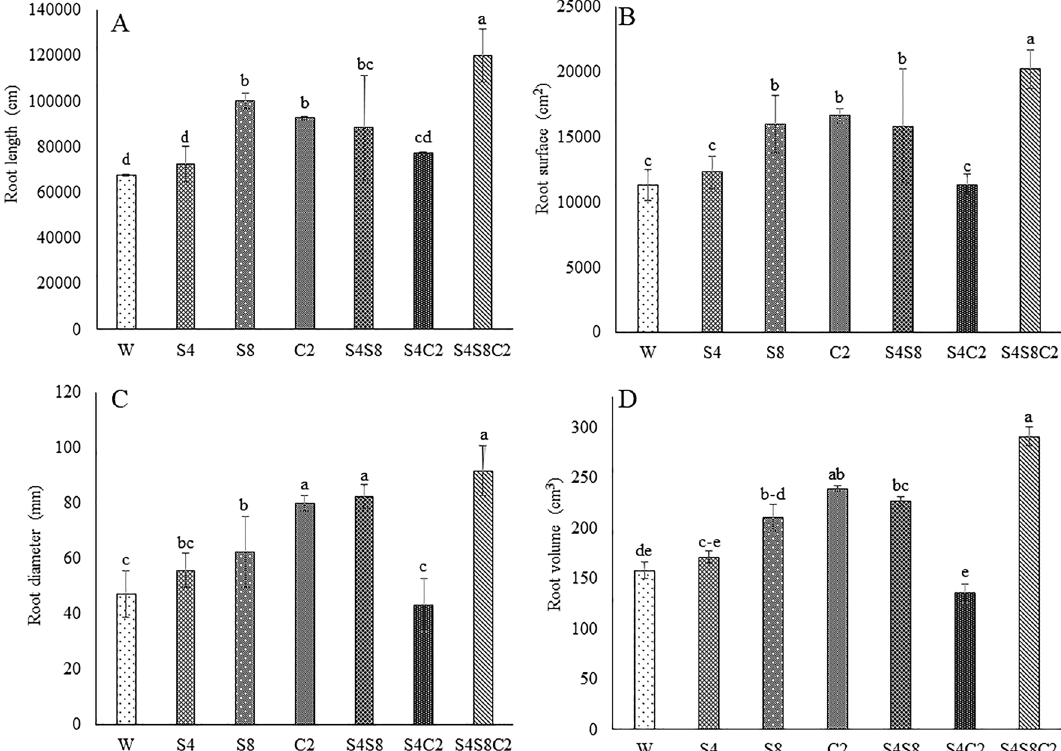
Figure 7. Effect of bacterial inoculation on root length, root surface, root diameter, and root volume. Different letters represent significant differences ( p < 0.05) according to the LSD test. W: uninoculated plant as control, S4: B. subtilis S42, S8 : E. cloacae S81, C2: P. azotoformans C2-114, S4S8: co-inoculation B. subtilis S42 and E. cloacae S81, S4C2: co-inoculation B. subtilis S42 and P. azotoformans C2-114, S4S8C2: mix of all